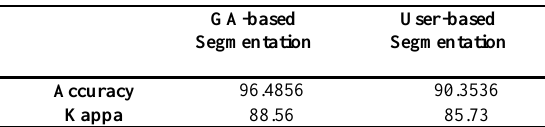
Table 1. Segmentation parameters found by GA and the user